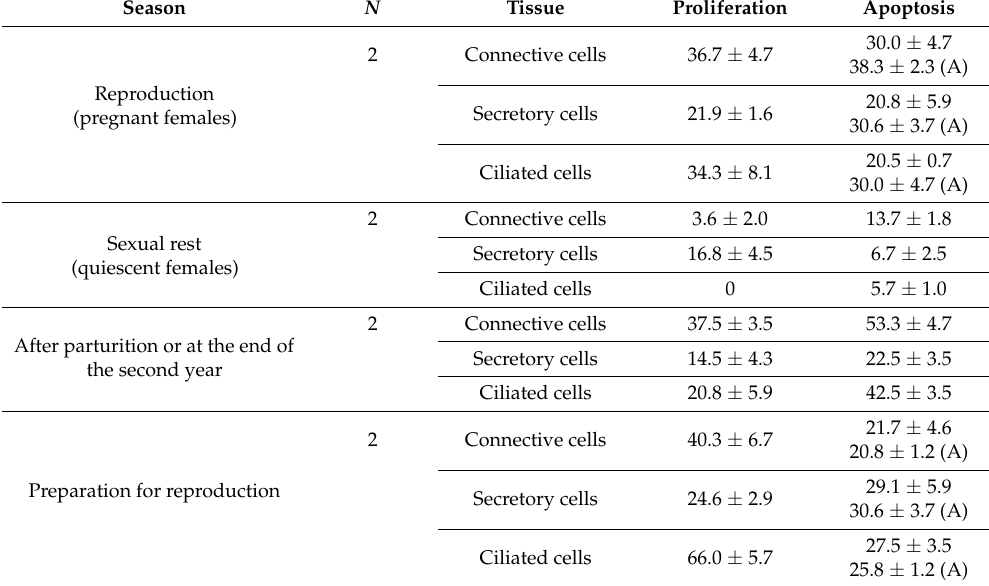
Table 7. Proliferation indexes (Ki67) and percentages of apoptotic cells (TUNEL/Apostain) in oviduct of Typhlonectes compressicauda during the year. (A): apoptosis detected with Apostain method. N : number of